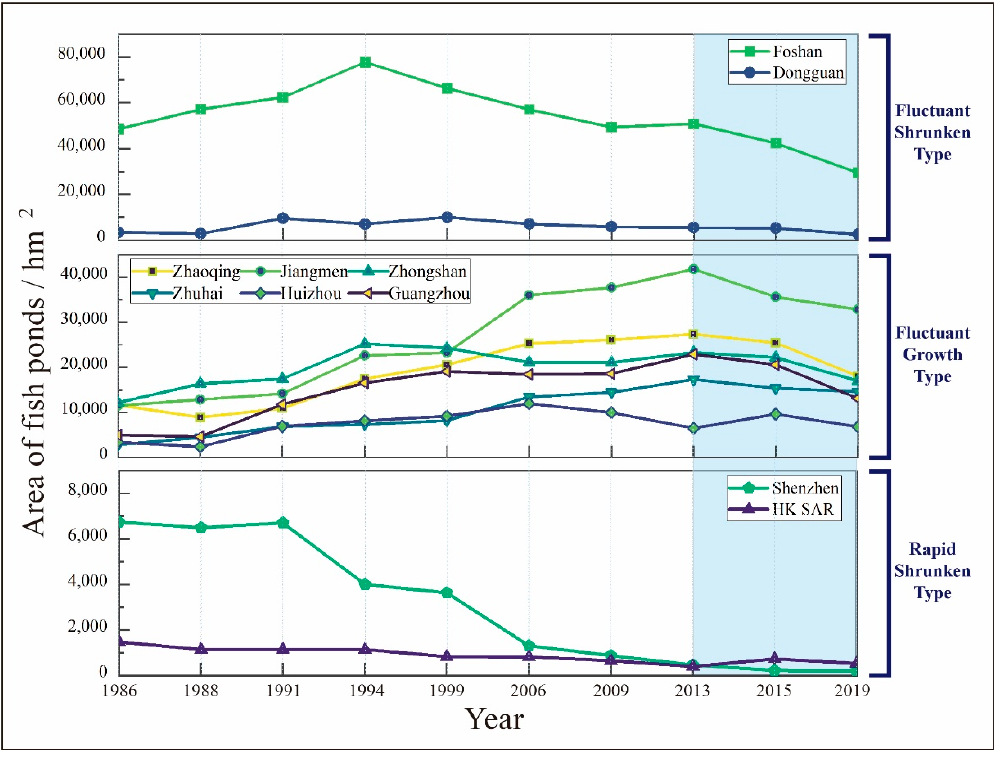
Figure 10. The trends for three representative changes in fish ponds in the GBA.